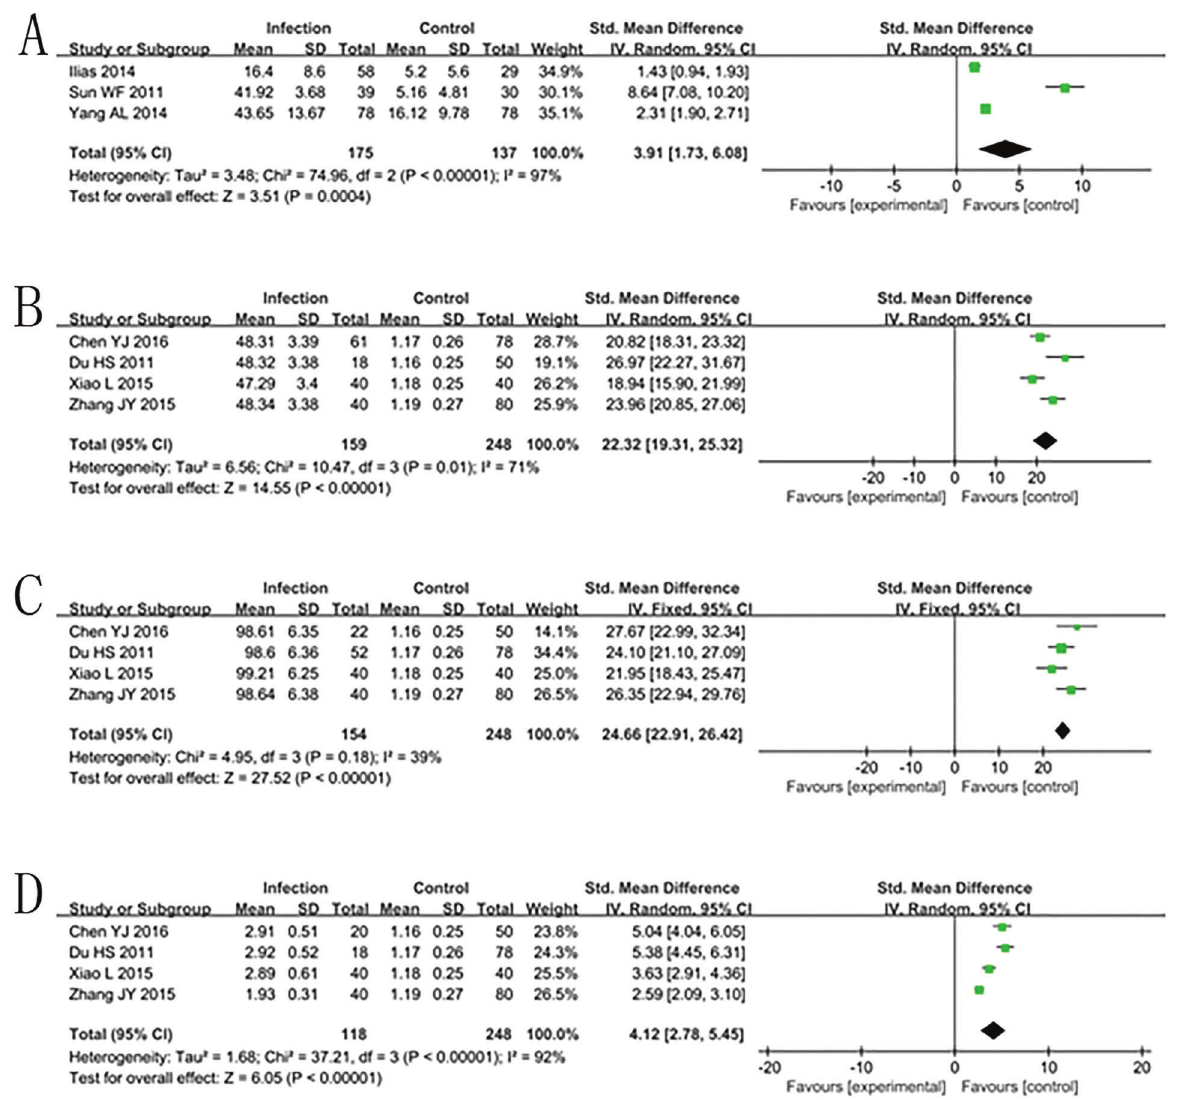
Figure 5. Forest plot for the concentration of CRP between A ) bacterial infection and control group, B ) G + bacterial infection and control group, C ) G – bacterial infection and control group, and D ) fungus infection and control